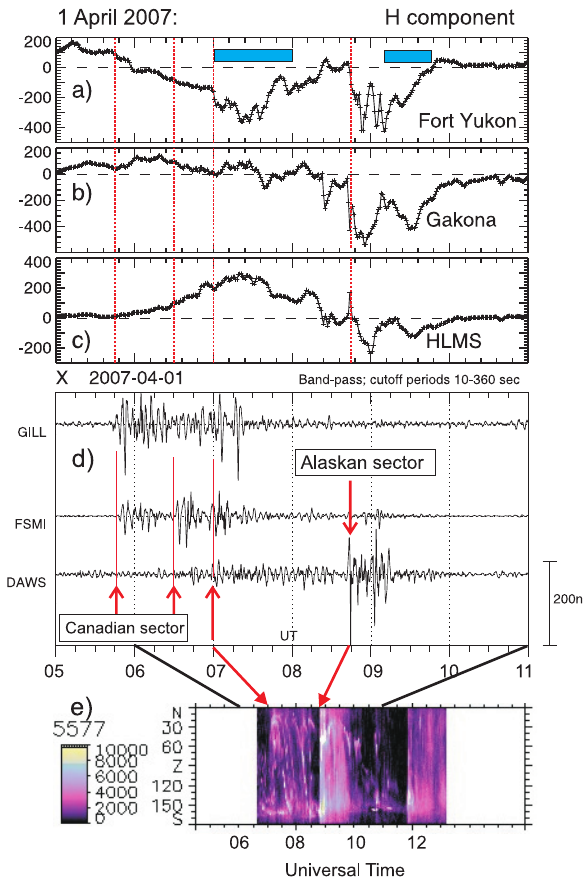
Fig. 5. (a–c) Magnetic H-components according to measurements at Fort Yukon, Gakona and High Latitude Monitoring Station on 1 April 2007. Horizontal blue bars on panel (a) denote the periods of high-velocity echo detection with the HOK radar. (d) Pi2 mag- netic pulsations in the X-component of the Earth’s magnetic field at Canadian stations Gillam, Fort Smith and Dawson. (e) Poker Flat (Alaska) photometer records of the auroral luminosity in 557.7nm line. The moments of the substorm onsets are indicated by vertical lines and